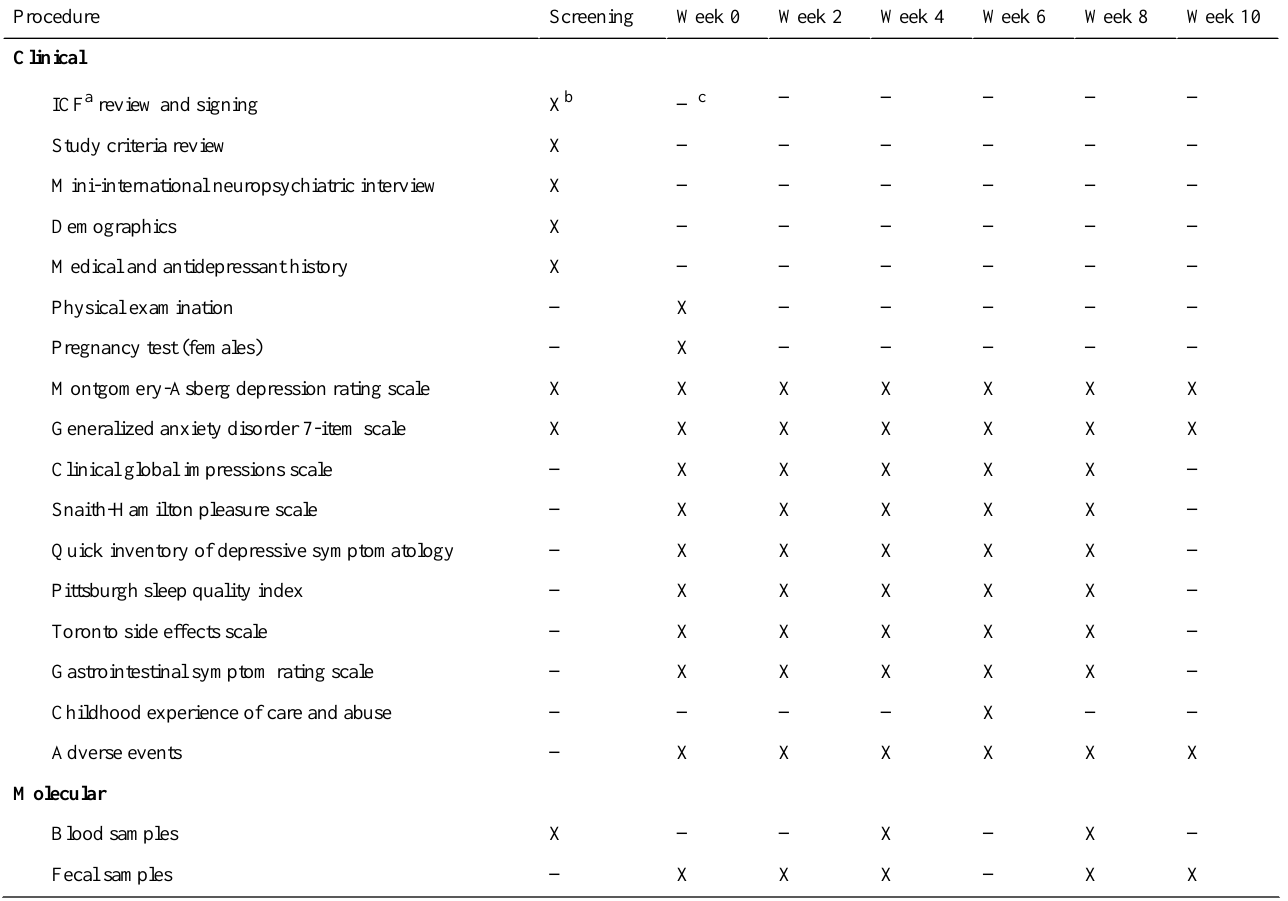
Table 2. Study visit